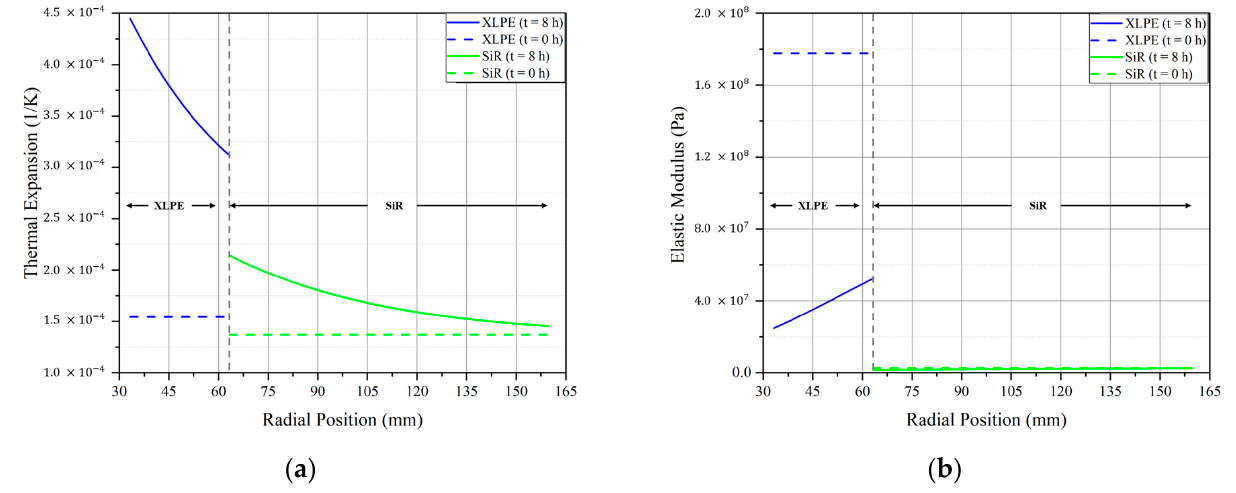
Figure 11. Distribution of thermal expansion and elastic modulus of XLPE and SiR: ( a ) Thermal expansion; ( b ) Elastic modulus.